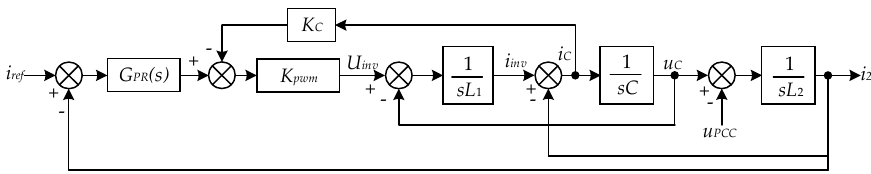
Figure 2. The control diagram of the current and damping control loop.